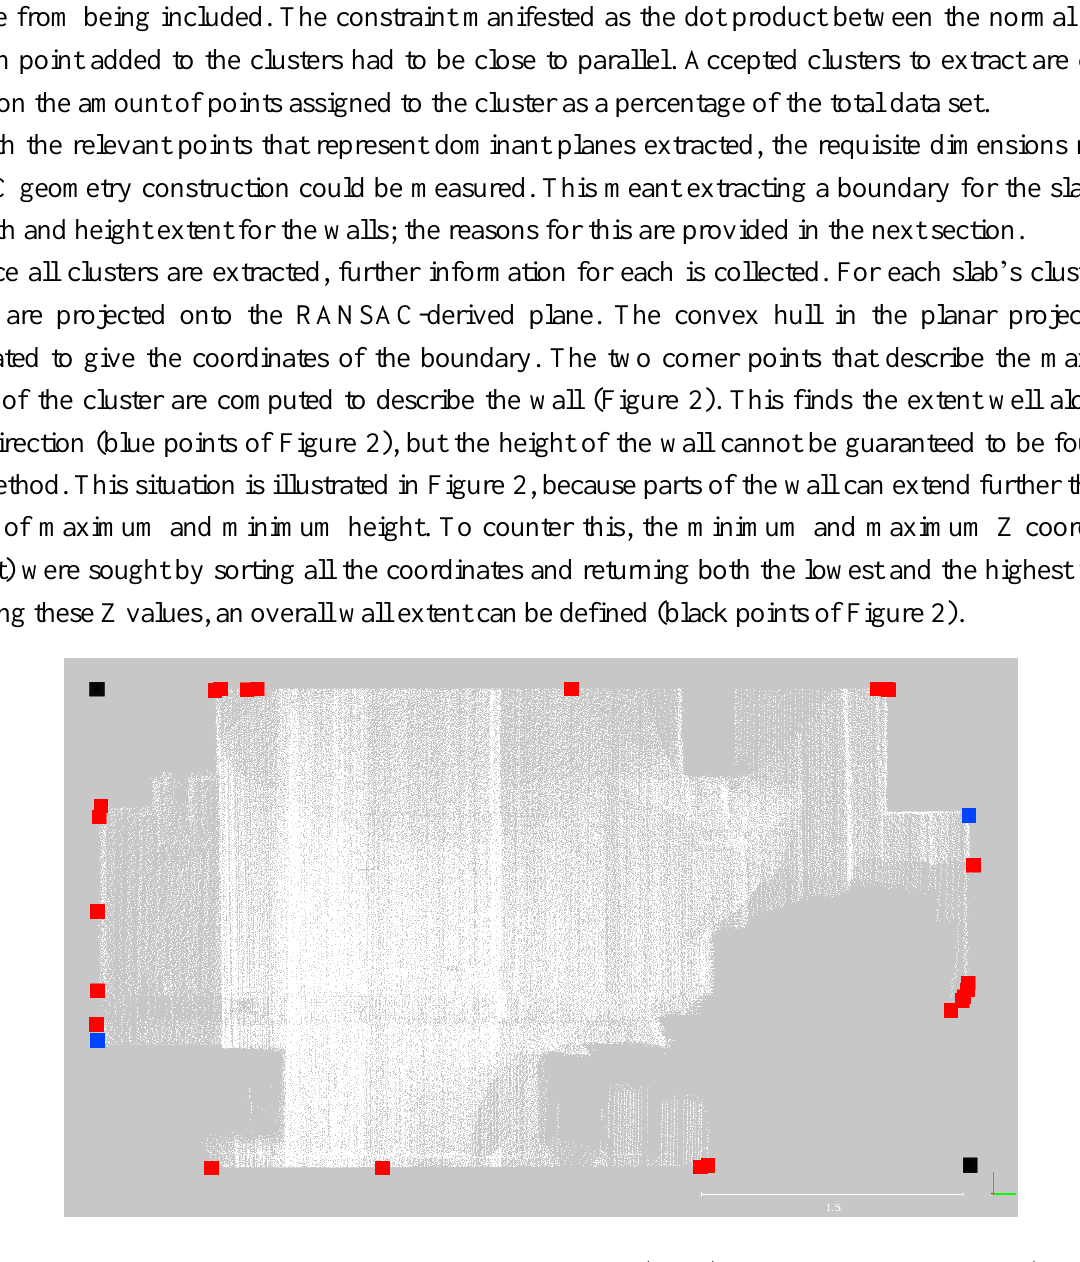
Figure 2. Example plot of minimum and maximum (black) and maximum segment (blue) coordinates on the points of a convex hull (red) calculated for a wall cluster point cloud